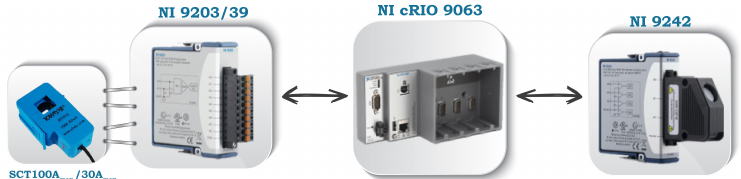
Figure 3. Basic components of IMPEC